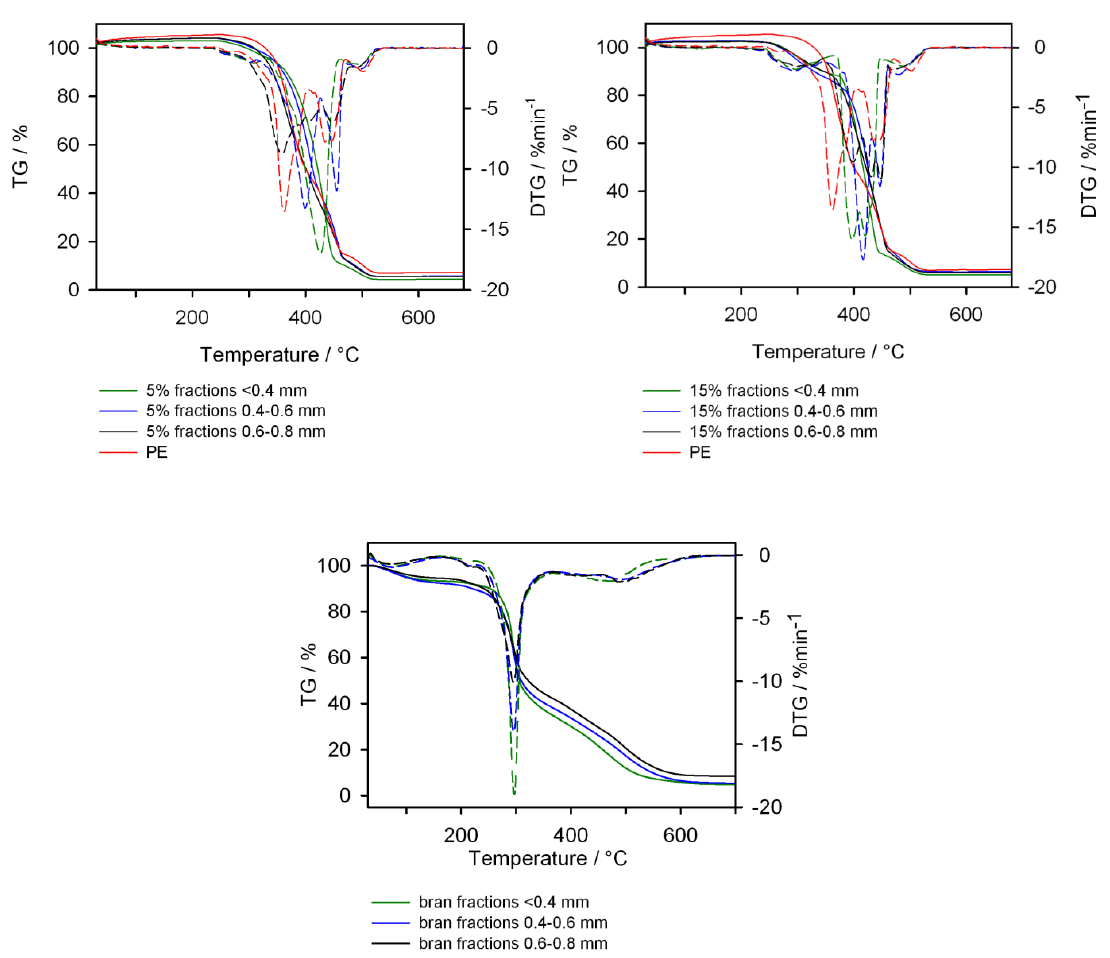
Figure 19. TG (continuous line) and DTG (dashed line) curves of components and composites with different bran content.